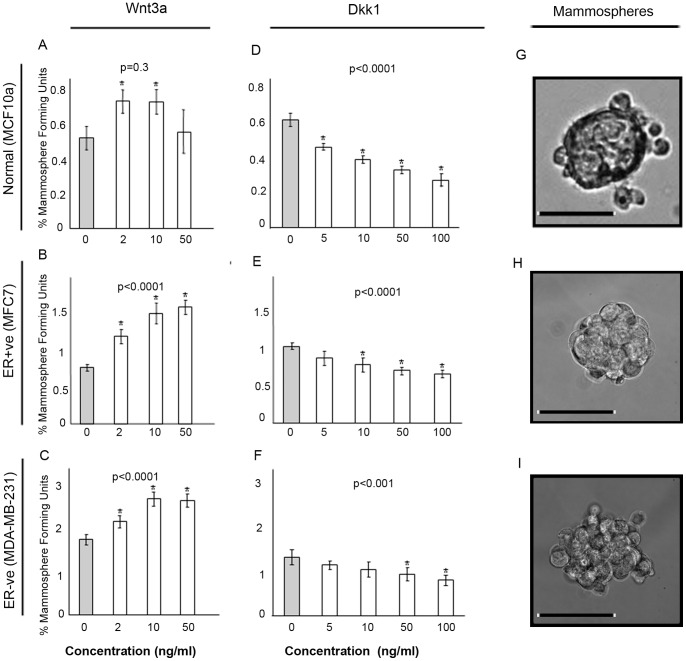
Modulation of Wnt signalling in normal and breast cancer cell lines.Single cells were plated in non-adherent conditions and treated with increasing concentrations of either Wnt3a (0–50 ng/ml) or DKK1 (0–100 ng/ml) and cultured for 7 days and number of mammospheres counted. Wnt3a treatments are displayed in the left panel and DKK1 treatments in the right panel. Light grey bars represent untreated control A) MCF10a cells (Wnt3a) B) MCF7 cells (Wnt3a) C) MDA-MB-231 cells (Wnt3a) D) MCF10a cells (DKK1) E) MCF7 cells (DKK1) F) MDA-MB-231 cells (DKK1). Data is expressed as % mammosphere formation units. P values were generated by ANOVA. Asterisks mark individual comparisons which reached statistical significance * <0.01 ** <0.001 generated by a T-test. G) Image of a MCF10a mammosphere H) Image of an MCF7 mammosphere I) Image of an MDA-MB-231 mammosphere. Scale bar represents 50 µM.